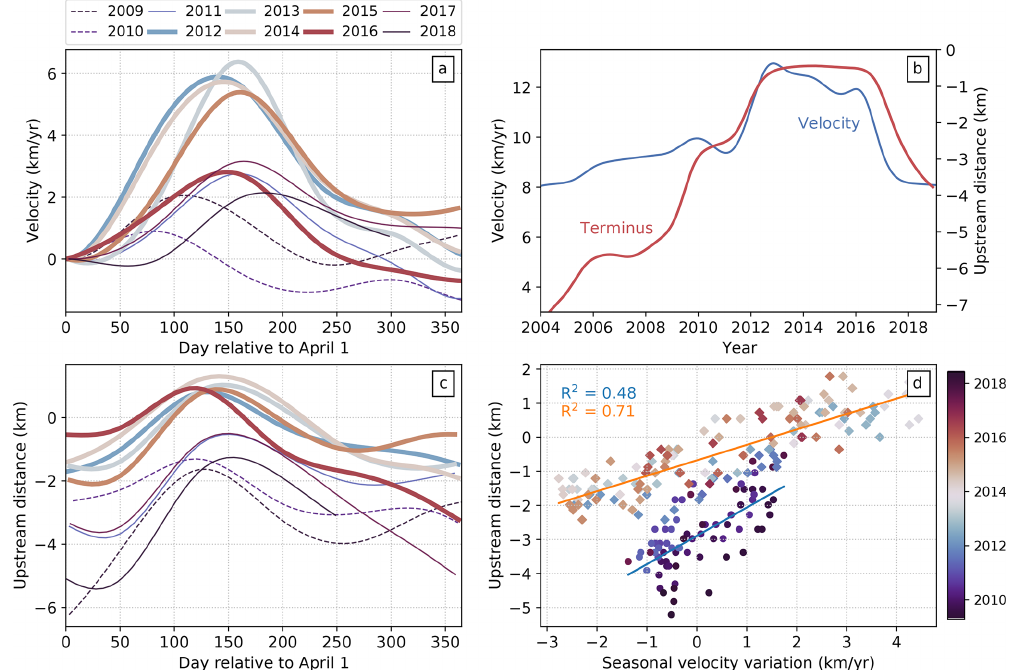
Figure 7. Comparison between time series of observed terminus positions and ice velocities at various timescales. (a) Seasonal ice centerline velocity at a point 1.4km upstream from the reference 2017 terminus position (location shown in Fig. 4). Speeds are shown on an annual timescale (referenced to 1 April) and are plotted relative to the speed on 1 April of the respective year. Line colors correspond to the color map in (d) , and bold lines correspond to the years 2012–2016 where strong amplification of the seasonal variations is observed (Fig. 1). (b) Long-term ice velocity and terminus position. Velocities are extracted from the same point as in (a) . Terminus positions are measured at the intersection of the time-varying calving front with the glacier centerline and are referenced to the position of the shallow pinning point highlighted by Cassotto et al. (2019). (c) Seasonal variations in terminus position with line colors and widths corresponding to lines in (a) . (d) Correlation between terminus position and seasonal velocity (i.e., ˆ d S ) at the same location as in (a) and (b) . Here, the points have been grouped into two temporal clusters: July 2011–January 2017 (diamonds) and all other times (circles), with the former time frame defined by the period when maximum seasonal retreat of the terminus position took it behind the reference pinning point. Thus, the scaling relationship between terminus position and velocities changes depending on whether the terminus has retreated beyond the pinning point. The text colors for the R 2 values correspond to the trend-line colors, while the point colors in (d) correspond to line colors in (a) and (b)